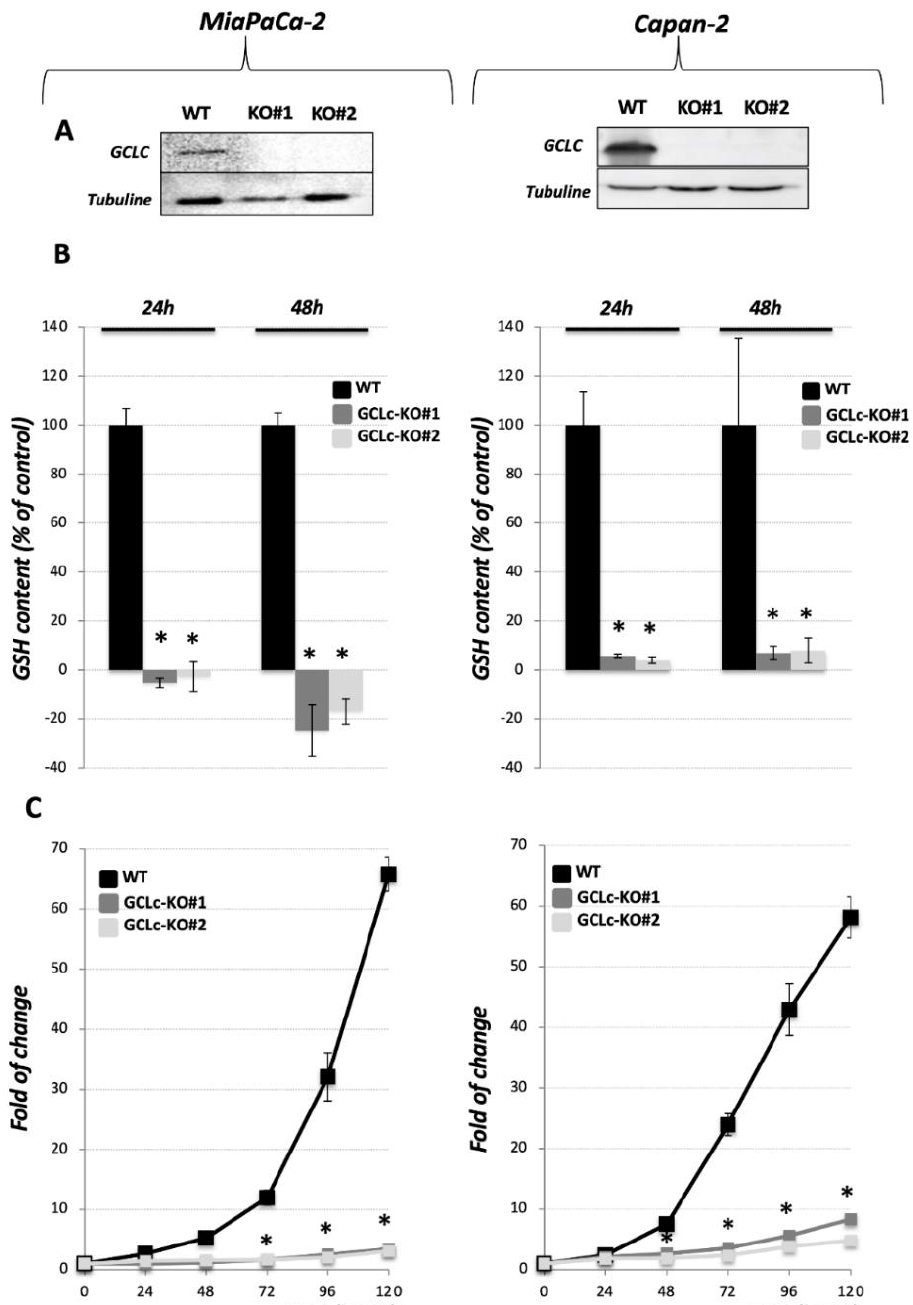
Figure 1. Gamma-glutamylcysteine (GCL) ligase determines cellular GSH content and cell pro- liferation of PDAC cells. ( A ). The expression of catalytic subunit of GCL (GCLc) was analyzed in MiaPaCa-2 and Capan-2 WT and two independent GCLc-KO cell lines (GCLc-KO#1 and GCLc-KO#2). Three independent experiments were performed, and representative blots are shown. ( B ). Relative intracellular GSH level was measured in WT and GCLc-KO cells of two PDAC cell lines after 24 h and 48 h upon seeding in the standard DMEM media. GSH content was normalized to the number of cells. Data shown represent the mean ± SEM; n = 3, * p < 0.05, comparison with corresponding WT control. ( C ). Proliferation of MiaPaCa-2 and Capan-2 WT and GCLc-KO cells seeded in the standard DMEM conditions. Proliferation rates are presented as fold of change (mean ± SEM; n = 3), * p < 0.05, comparison with WT control